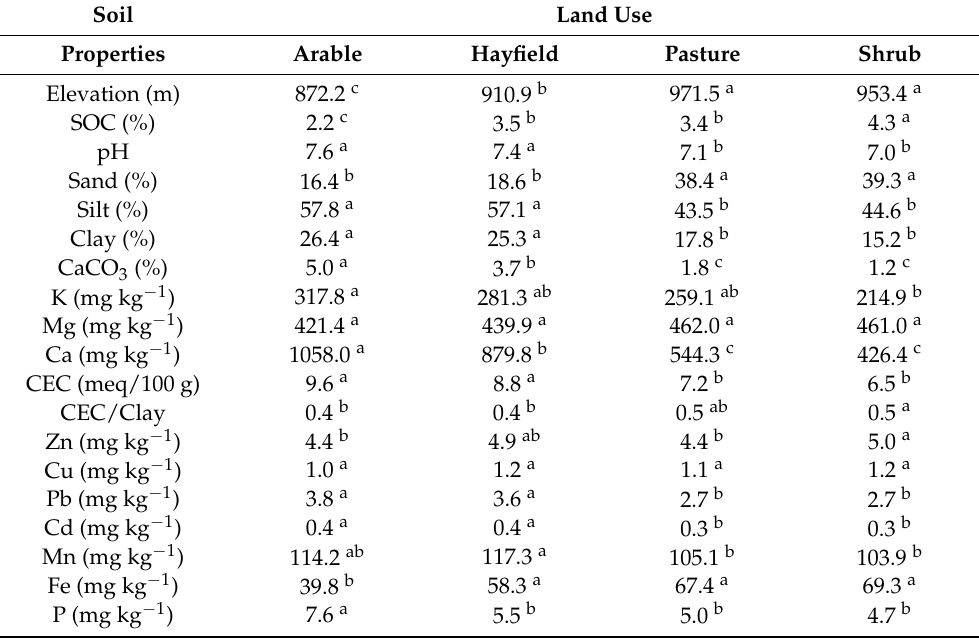
Table 2. Soil properties as affected by land use or elevation. Within each row, means labelled with the same letter are not significantly different at p < 0.05. Soil Land Use Properties Arable Hayfield Pasture